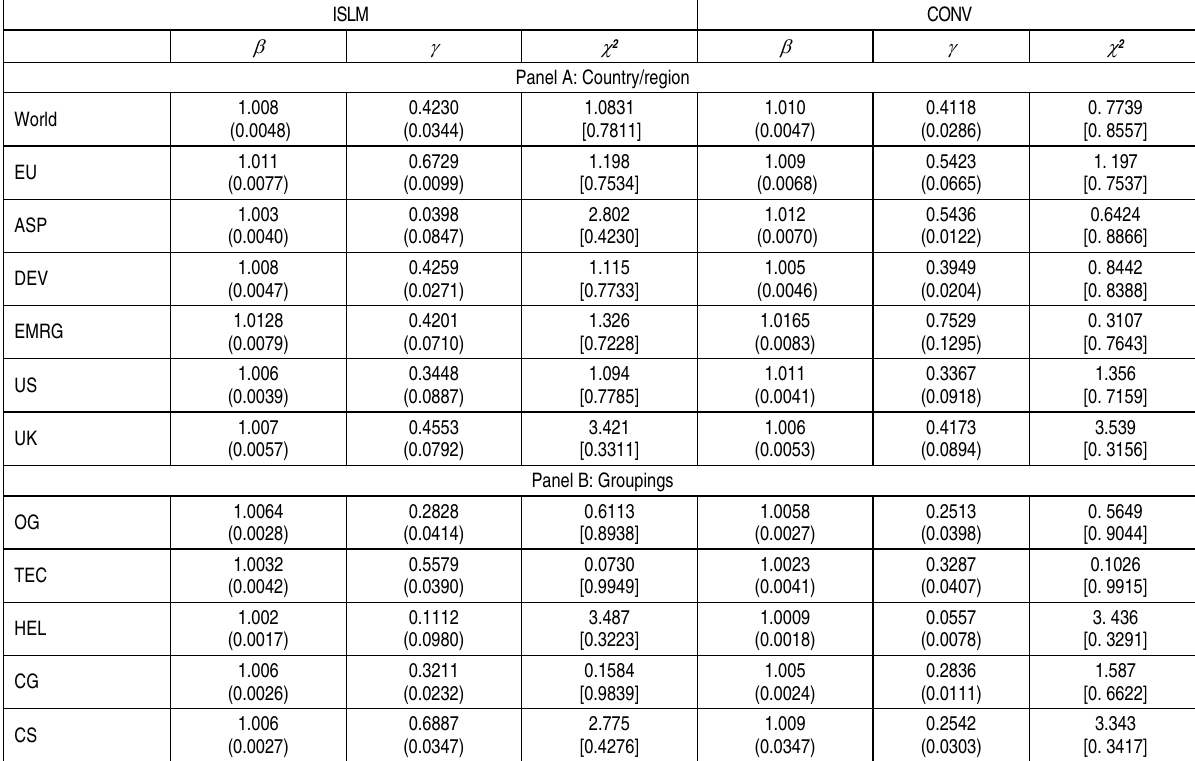
Table 9. GMM estimations of habit formation model